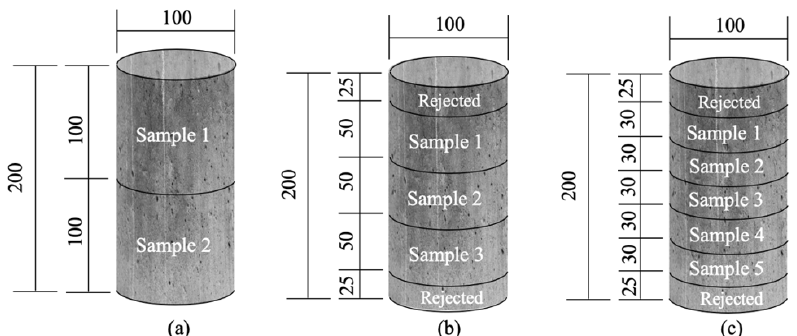
Figure 1. Sample cut scheme (dimensions in mm): (a) for ASTM C1556 [14] test method; (b) for NT Build 492 method; (c) for UNE 83987 [13]